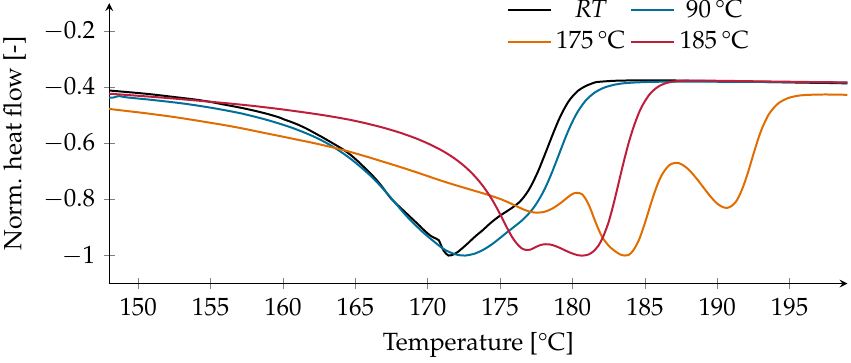
Figure 2. Normalized heat flow over the temperature.